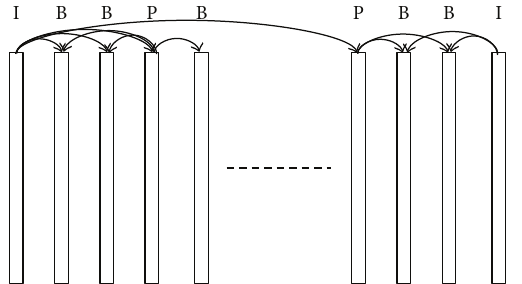
Figure 1: The MPEG-2 GoP and dependencies between I, P, and B